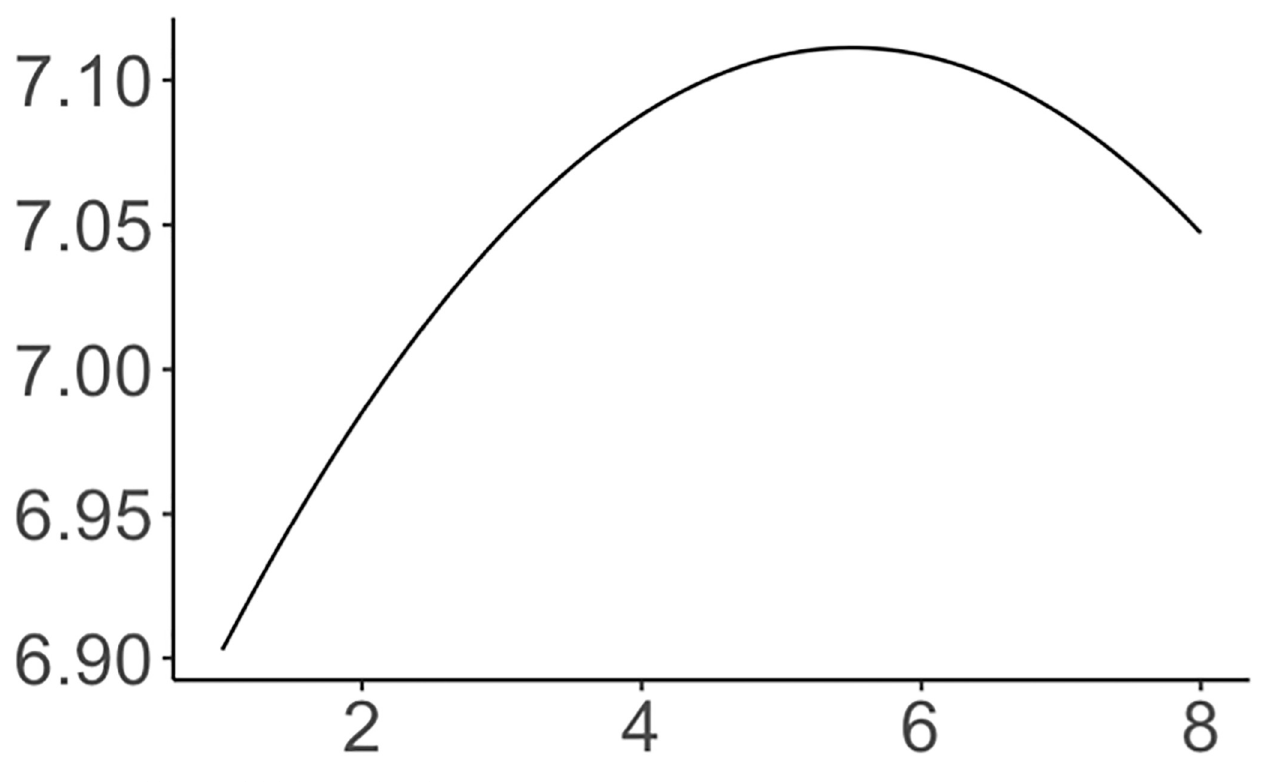
Fig 17. Estimated function of global temporal trend.